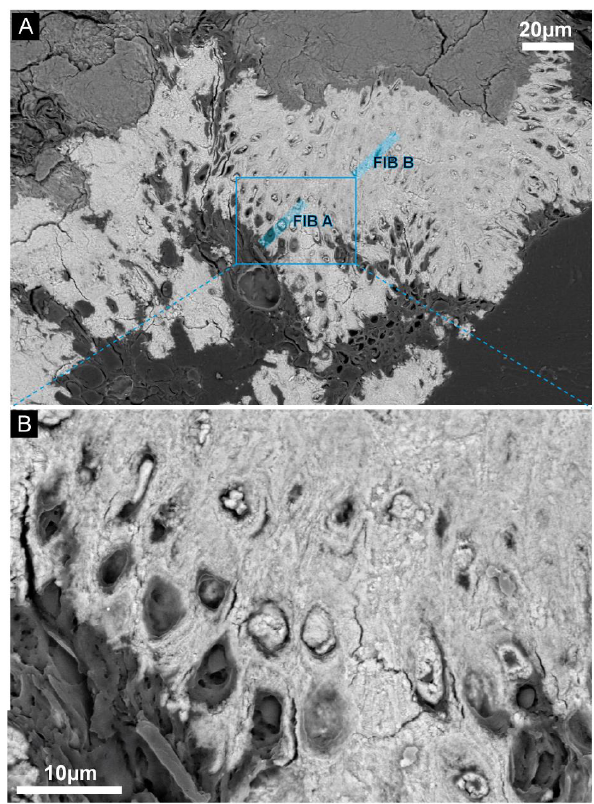
Figure 2. Fossilization gradient of Pleurocapsales in aragonite observed by SEM in 2 Fig. 2. Fossilization gradient of Pleurocapsales in aragonite ob- backscattered electron mode. (A) area B (as outlined in Figure 1) showing progressive 3 served by SEM in backscattered electron mode. (A) area B (as out- encrustation of cells in aragonite. Locations of FIB foils are shown. FIB foil A corresponds to 4 lined in Fig. 1) showing progressive encrustation of cells in arago- nite. Locations of FIB foils are shown. FIB foil A corresponds to the beginning of the fossilization gradient while FIB foil B was cut in totally encrusted cells. 5 the beginning of the fossilization gradient while FIB foil B was cut (B) Close-up of area B showing the textural relation between cells and aragonite. In some 6 in totally encrusted cells. (B) Close-up of area B showing the tex- tural relation between cells and aragonite. In some cells, the inner part remains totally organic while in others only the wall is visible, while the inner part being filled by